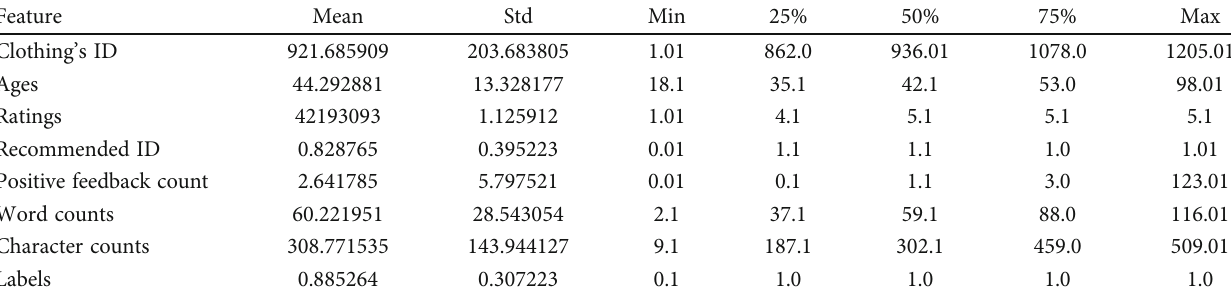
Table 3: Description of statistical analysis for women ’ s data of